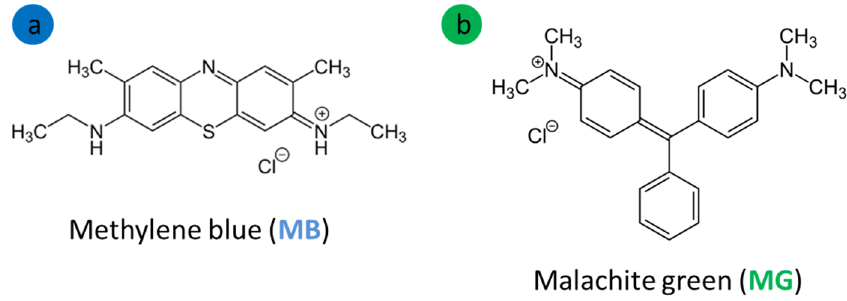
Figure 1. The molecular structures of the studied basic dyes.